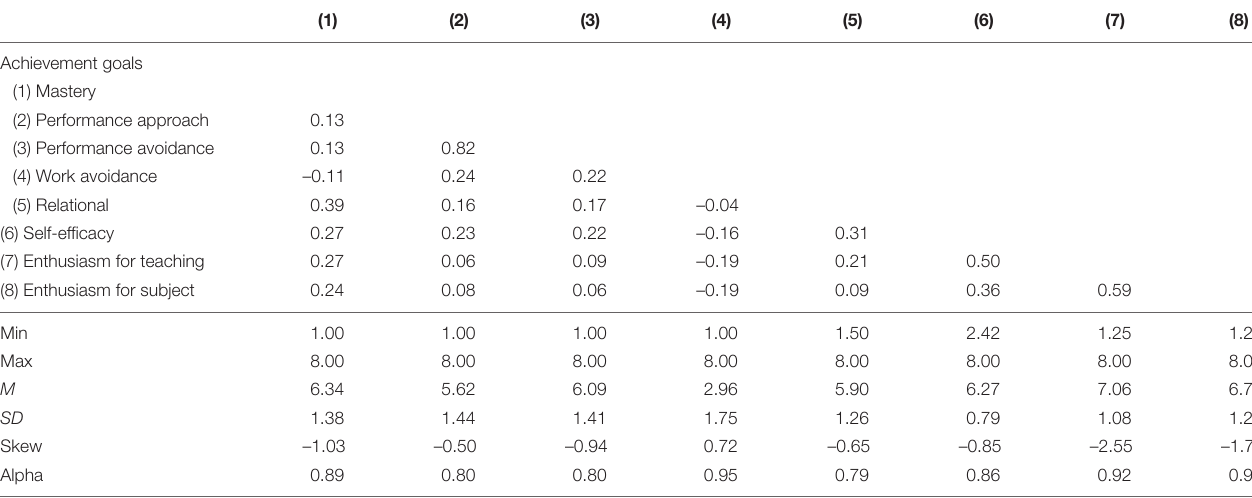
TABLE 2 | Descriptives and manifest correlations of instructors’ achievement goals, enthusiasm, and